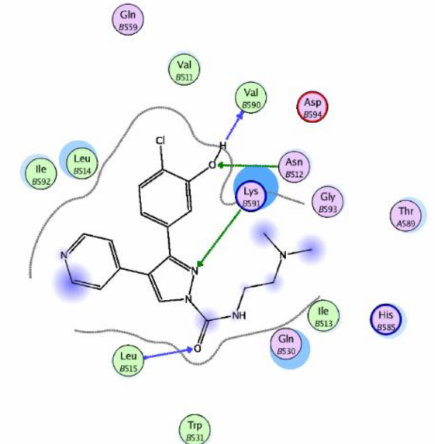
Figure 70. Structures of pyrazole-based RAF kinase inhibitors and their IC 50 /Ki values or per- centage inhibition.